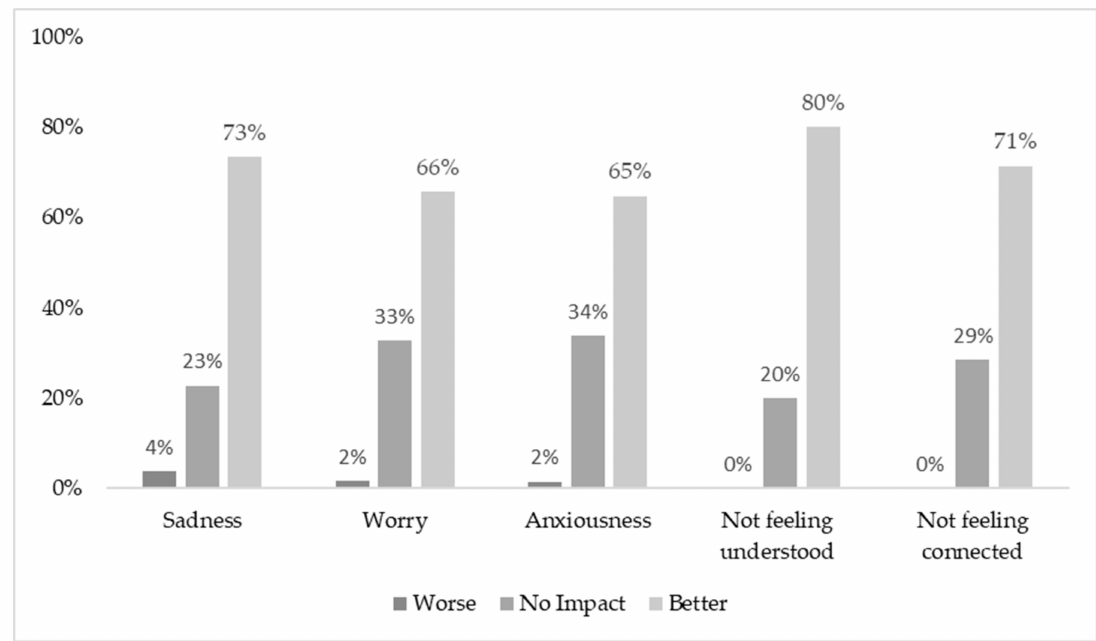
Figure 6. Impact of Canteen Connect version